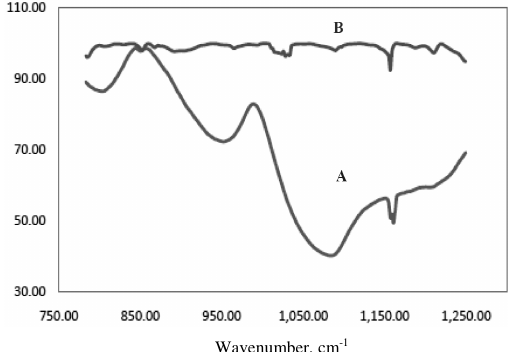
Figure 2. IR spectroscopy of recovered Preyssler heteropolyacid in nano form (A) and bulk form